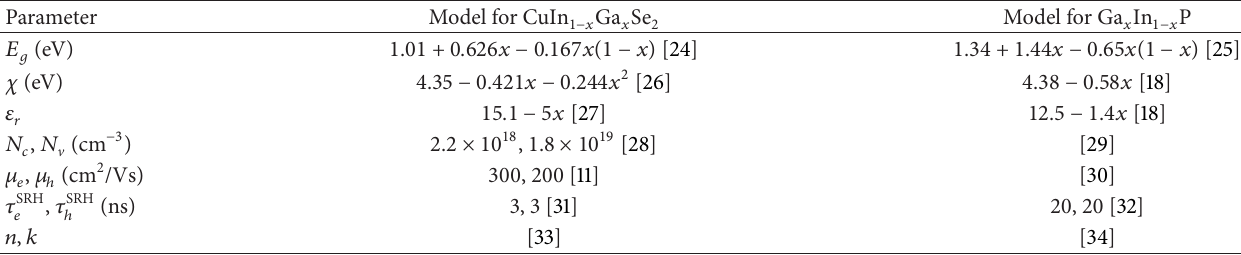
and Ga 𝑥 In 1−𝑥 2